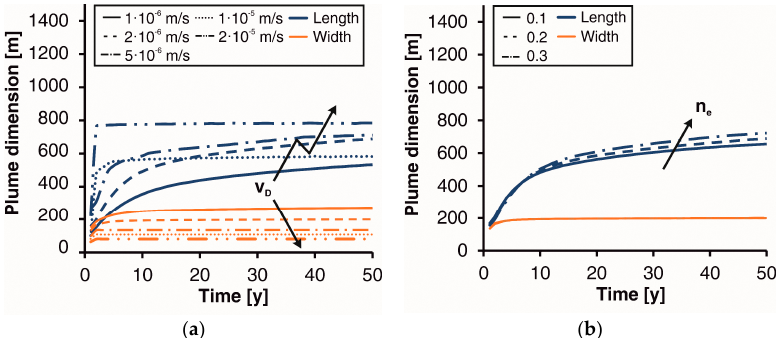
Figure 5. Time evolution of plume dimensions with Darcy velocity (cid:1874) (cid:3005) ( a ) and effective porosity (cid:1866) (cid:3032) ( b ); isotherm ∆ T = 1 °C.